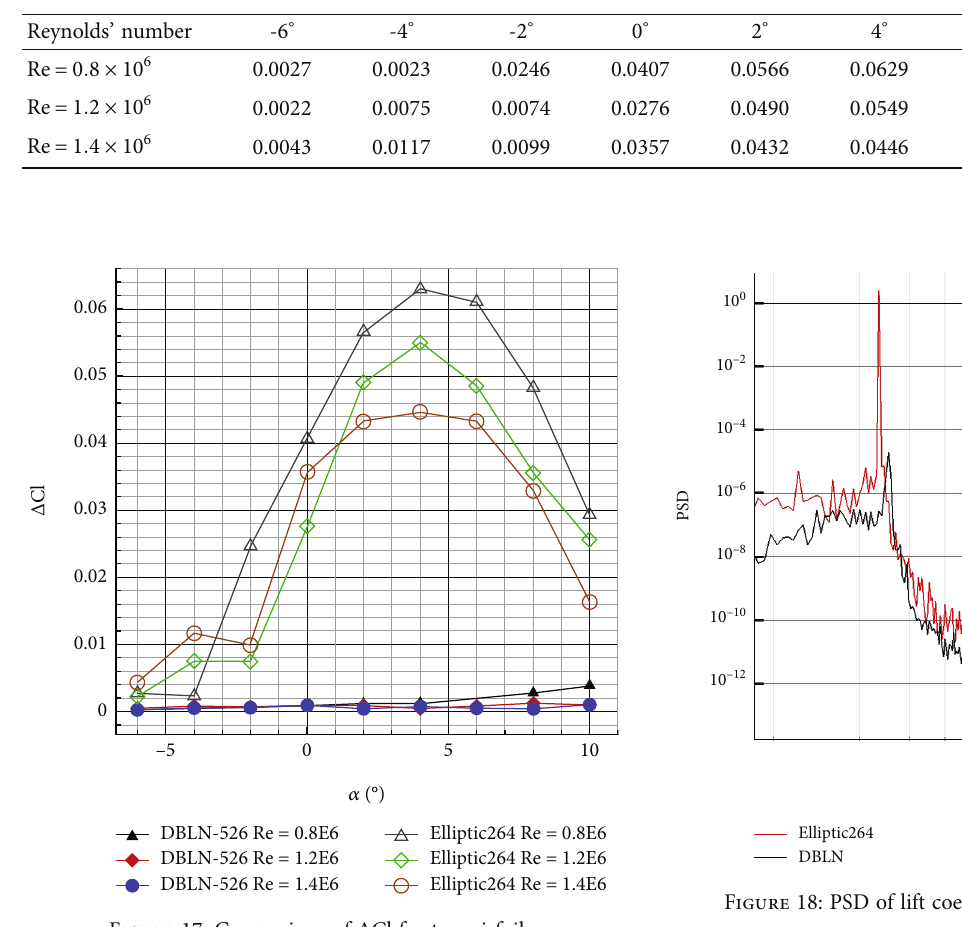
Table 4: Δ Cl for Elliptic264 airfoil.